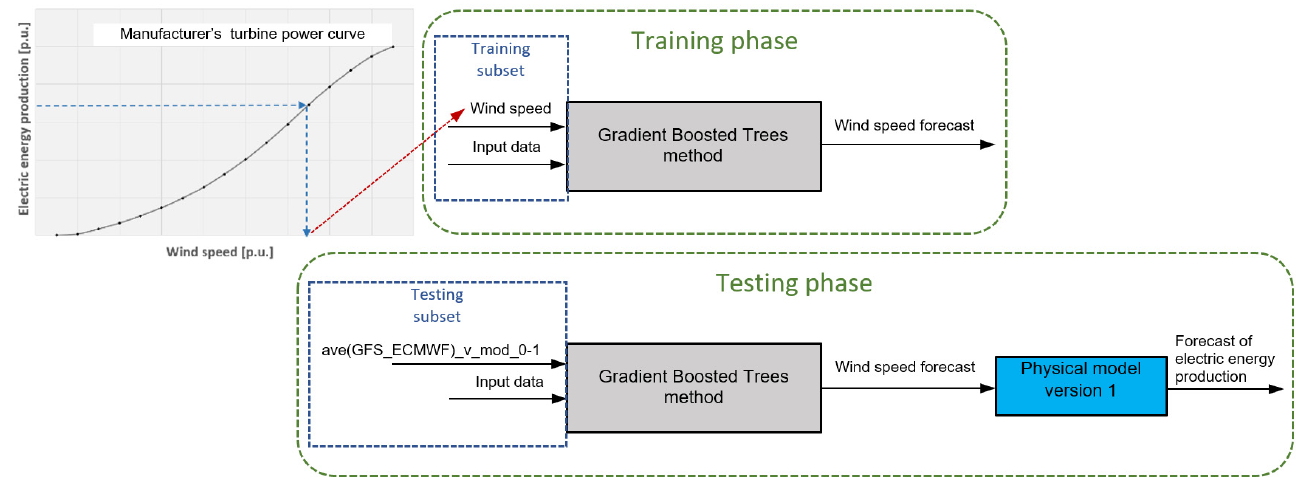
Figure 16. General structure of hybrid method—Physical model version 1 with input data as wind speed forecast from Gradient-Boosted Trees method. A summary description of thirteen tested forecasting methods is shown in Table 4. Table 4. Summary description of thirteen tested forecasting